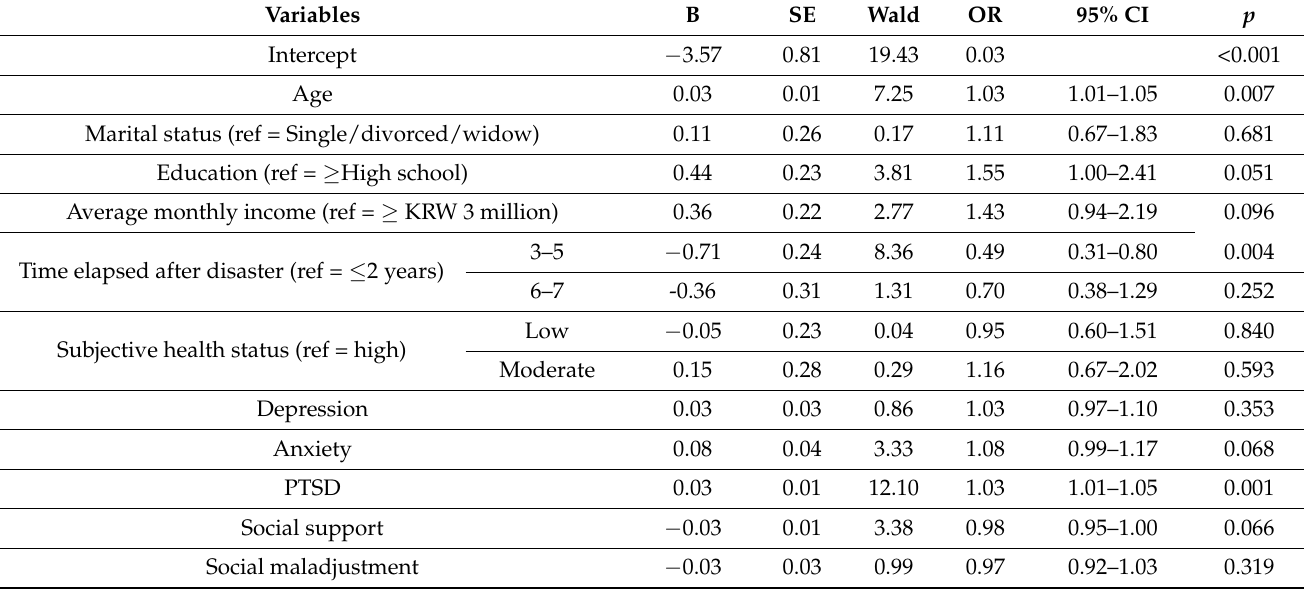
Table 4. Factors associated with sleep medication